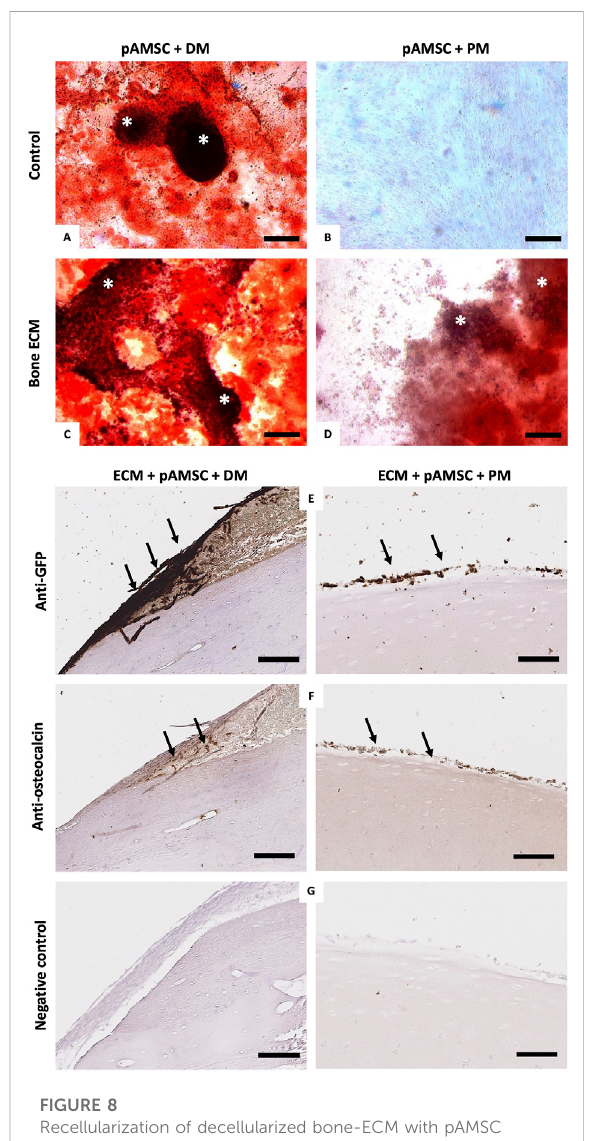
FIGURE 8 Recellularization of decellularized bone-ECM with pAMSC and osteogenic differentiation. (A – D) : Alizarin red staining performeddirectlyinthecontrolculturewellsseededwithpAMSC after 7 days of culture with DM (A) or PM (B), as well as in the culture wells with pAMSC seeded on bone ECM cultured with DM (C) or PM (D) after 22 culture days showed the formation of calci fi ed micro-nodules (*) in all conditions excepting the seeded cells cultured with PM only. All scale bars = 200 μ m. (E – G) IHC staining of respectively GFP (E) , osteocalcin (F), and negative control (G) of seeded pAMSC on bone ECM cultured with either DM (left) or PM (right) at 22 days of culture. Black arrows showed the positive osteocalcin staining corresponding to the GFP- pAMSC (All scale bars = 100